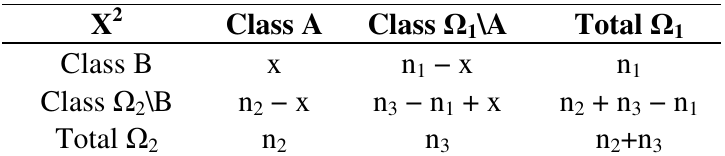
Table 9. 2 × 2 contingency table with one degree of